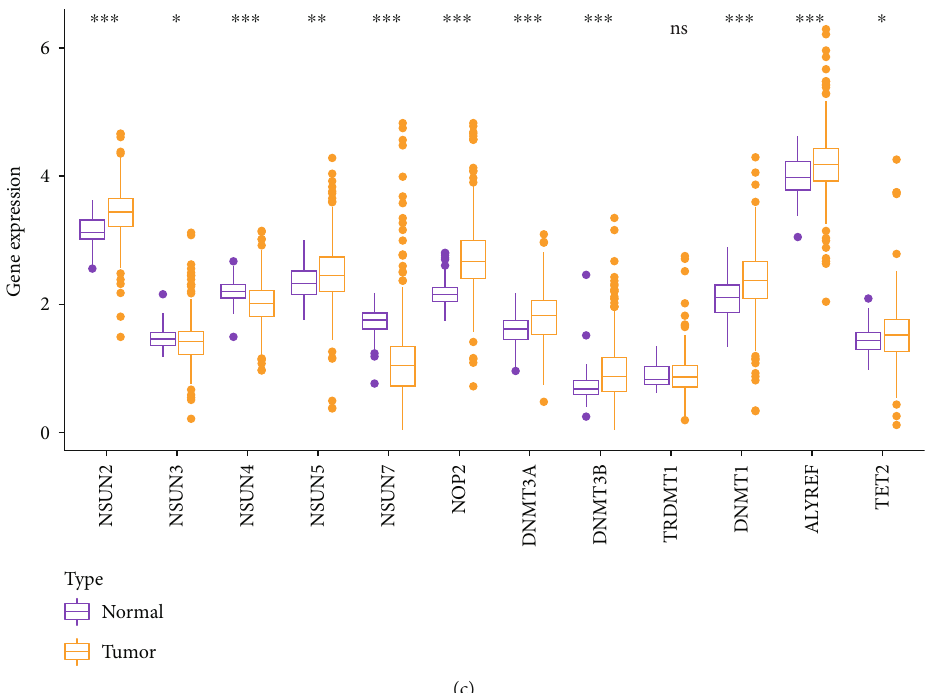
Figure 1: Di ff erent expression of m 5 C RNA methylation-related genes in ccRCC. (a) Schematic fl ow chart of N5-methylcytosine (m 5 C) RNA methylation. (b) The heatmap of twelve m 5 C RNA methylation regulators in 539 ccRCC and 72 normal tissues from the TCGA database. The color bar from red to green denotes high to low gene expression. (c) The expression of twelve m 5 C RNA methylation regulators in normal tissues and ccRCC from the TCGA database. ∗ p < 0 : 05 , ∗∗ p < 0 : 01 , and ∗∗∗ p < 0 : 001 . ns: no signi fi